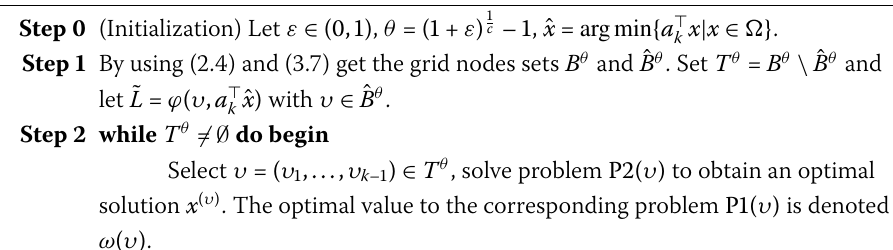
Algorithm  The improved